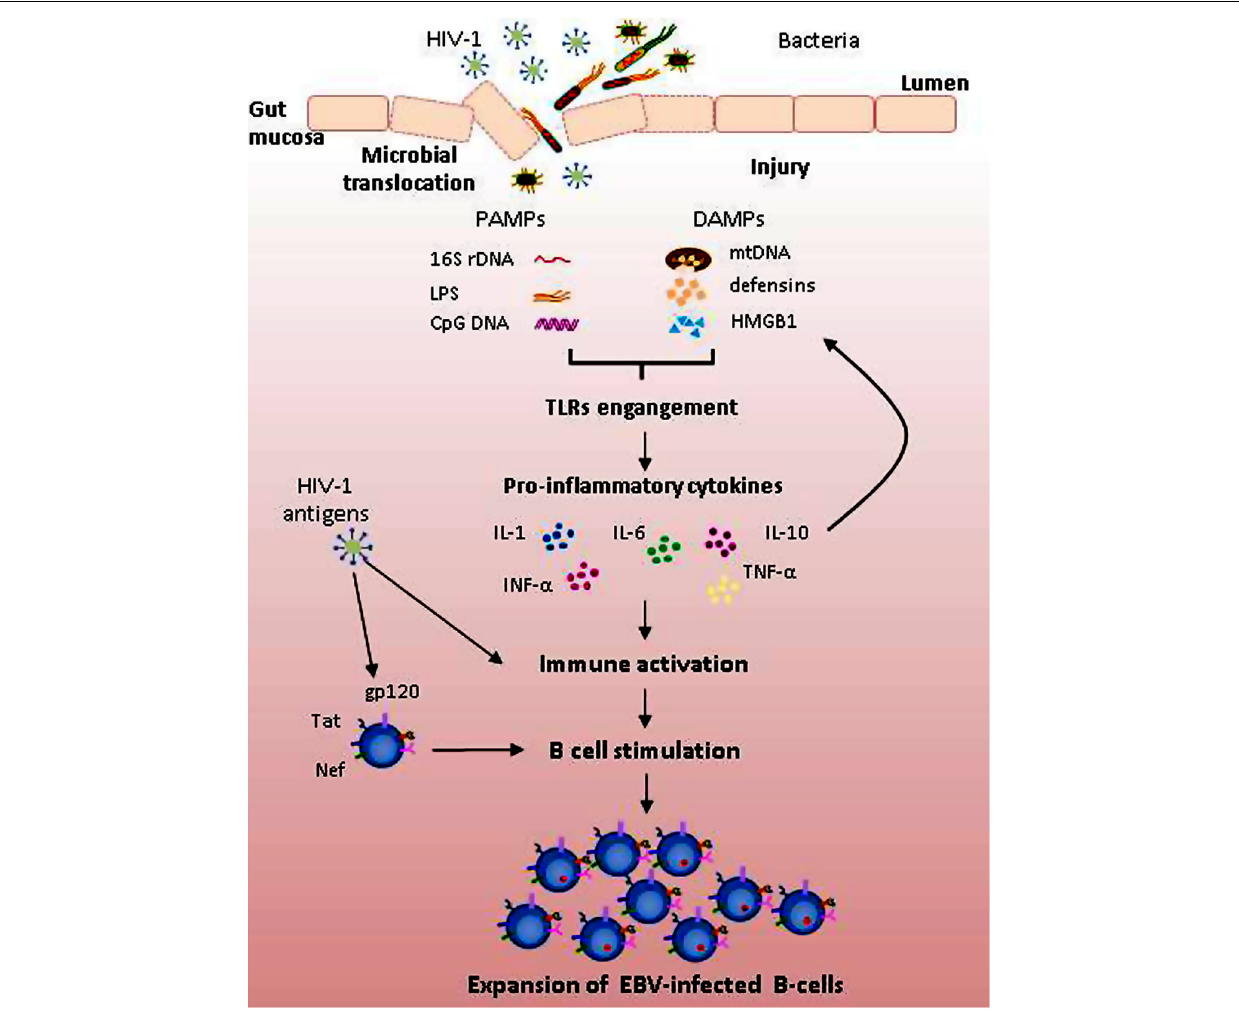
(PAMPs), such as LPS, 16S rDNA, and CpG DNA, and endogenous molecules created upon tissue injury (damage-associated molecular patterns, DAMPs), such as mitochondrial DNA (mtDNA), defensins and high mobility group box 1 (HMGB1) protein, by engagingToll-like receptors (TLRs) activate signaling cascade leading to increased transcription of pro-inflammatory cytokines. In this context, both EBV-infected and uninfected B cells are activated and may undergo proliferation; EBV-infected cells may overcome uninfected ones due to higher replicative capacity and telomerase